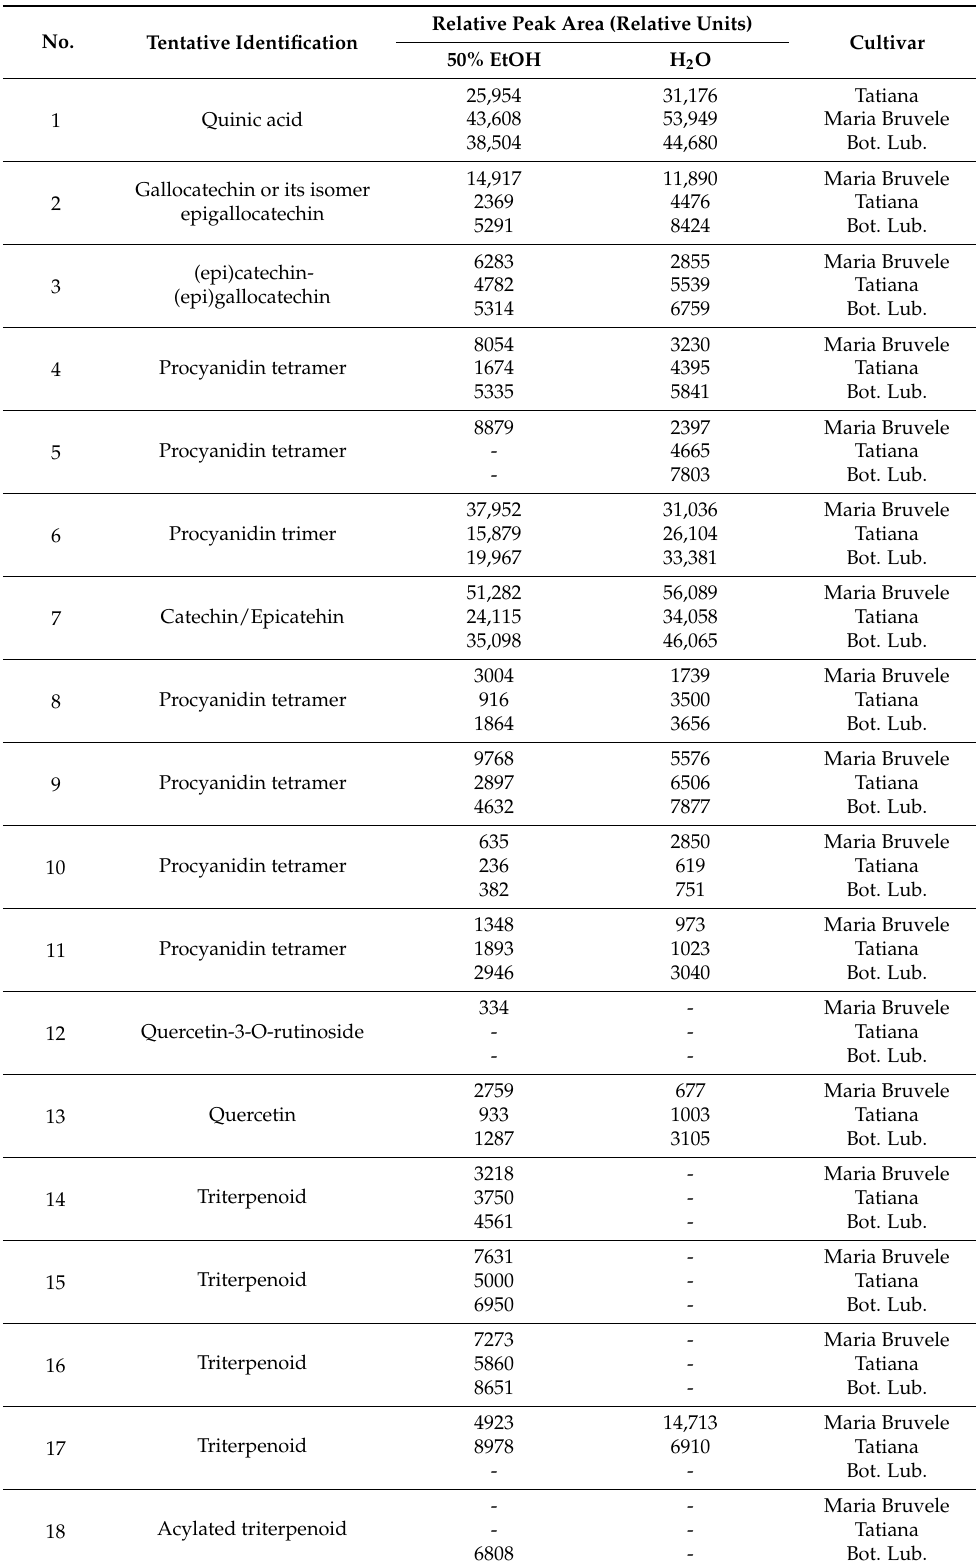
Table 2. The comparison of relative peak areas of dominant biologically active compounds calculated on mg/mg